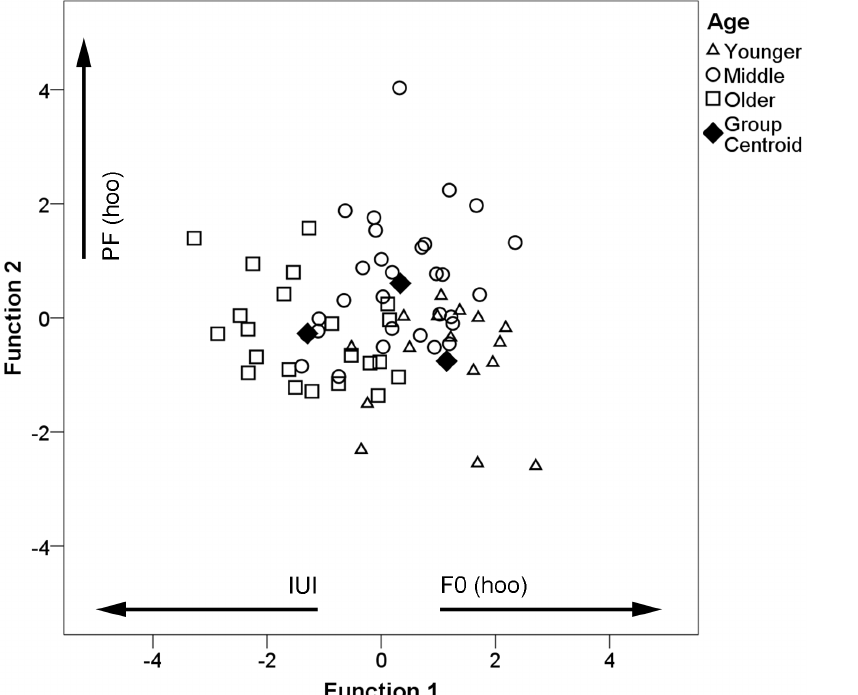
Figure 6. Discriminant scores for loud calls produced by males in different age classes for the first two canonical discriminant functions. The three age classes are denoted by different symbols. Variables showing loadings with an absolute value . 0.4 for each function are indicated along the axes.